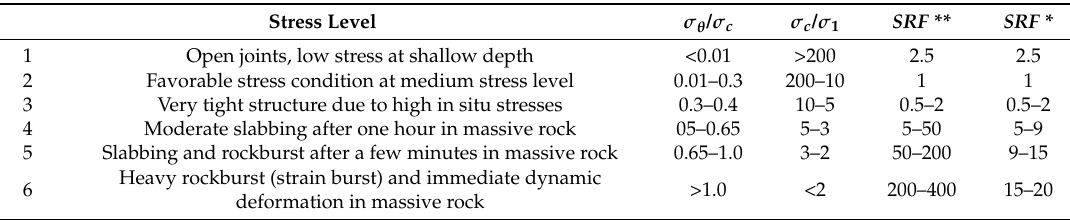
Table 2. The stress reduction factor ( SRF ) rating is the function of stress–strength ratios in the case of competent rock having rock-stress problems.